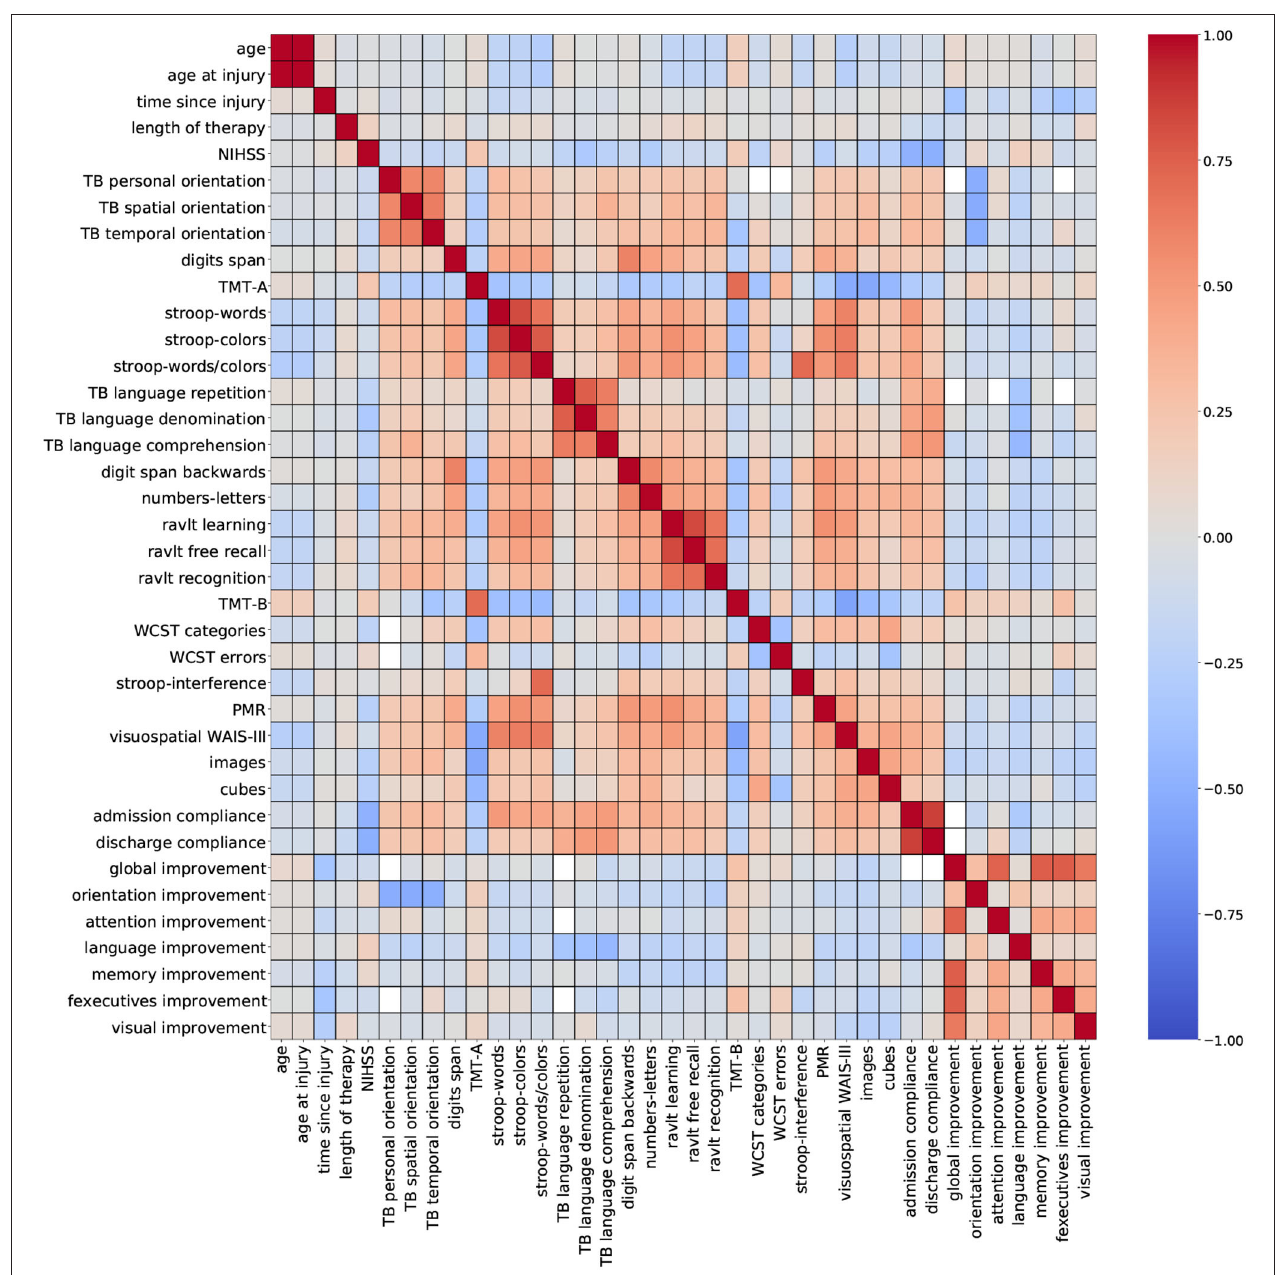
FIGURE 2 | Correlation outcomes from demographic + cognitive variables. Red: strong positive correlation (+1), blue: strong negative correlation (–1).